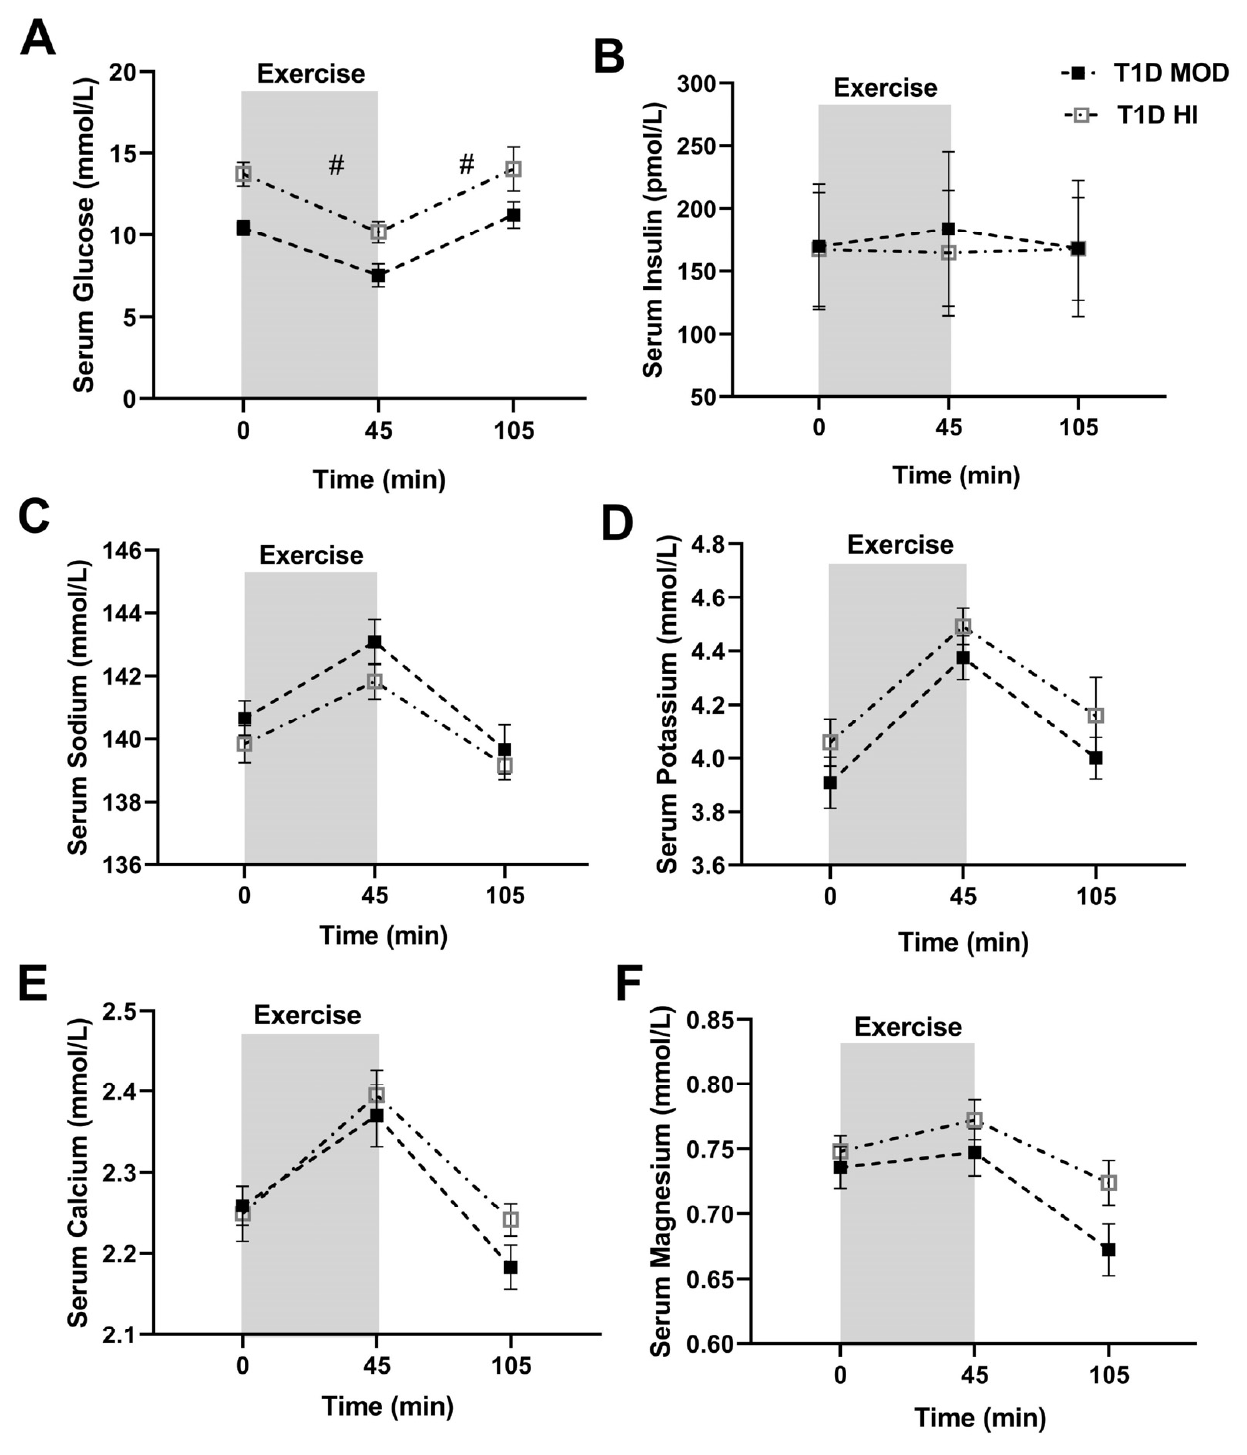
Figure 1. Serum concentrations (mean ± SEM) of glucose ( A ), insulin ( B ), sodium ( C ), potassium ( D ), calcium ( E ), and magnesium ( F ) before exercise (time 0), at the end of exercise (45 min), and at the end of the 60 min recovery (105 min) in T1D MOD (black squares) and T1D HI (grey squares). # shows significant differences (treatment effect) between MOD and HI from the beginning to the end of exercise and from the end of exercise to the end of recovery compared by ANOVA.